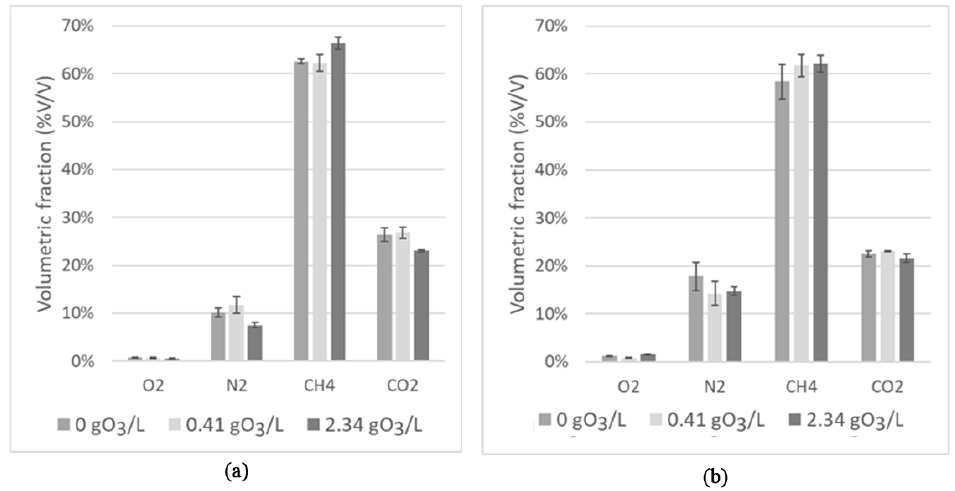
Figure 4. Biogas composition obtained within fermentation processes: ( a ) concentrated SAS; ( b ) non-concentrated SAS.